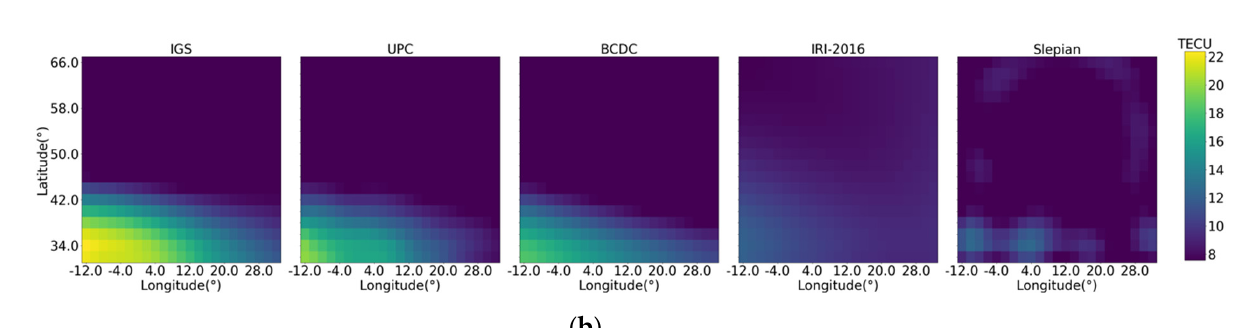
Figure 10. VTEC maps produced by IGS, UPC, BCDC, IRI − 2016 and Slepian during the geomagnetic disturbed time. ( a ) 12:00, 25 June; ( b ) 2:00, 23 June.